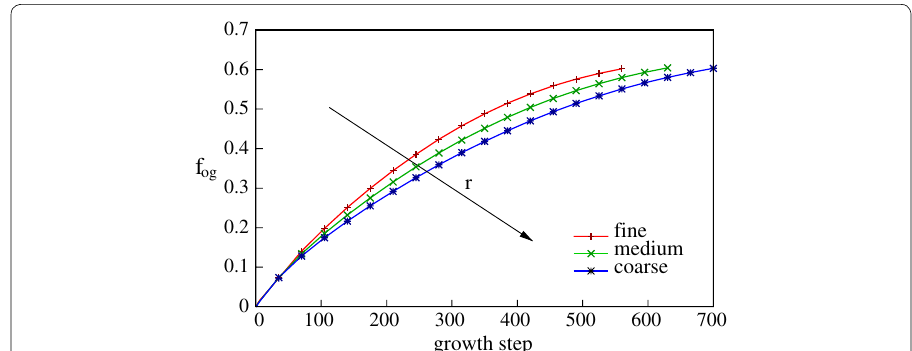
Fig. 5 Plots of overgrowth volume fraction f og with growth step for fine, medium, and coarse grains. Over- growth kinetics is inversely dependent (non-linear) on initial grain size